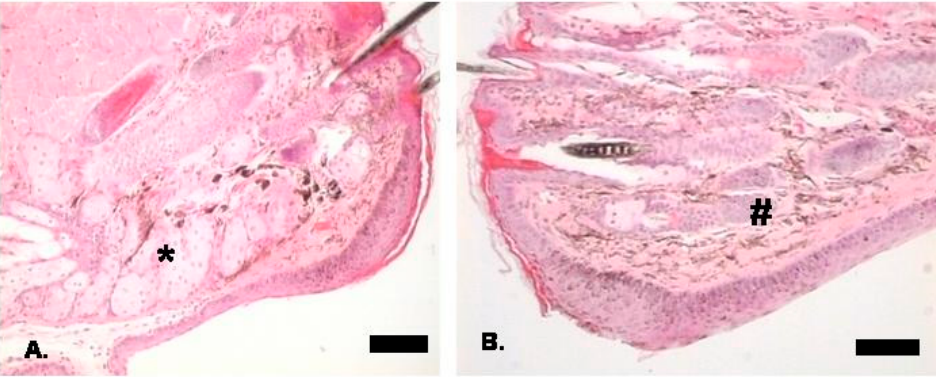
Figure 1. Histological appearances of the eyelid. ( A ) . Normal 129/Sv male mouse eyelid with * showing meibomian glands (H&E). Scale bar = 571 µ m. ( B ). Tabby mouse showing complete absence of the meibomian glands with # indicating normal anatomical site of meibomian glands (H&E). Scale bar = 233 μ m.